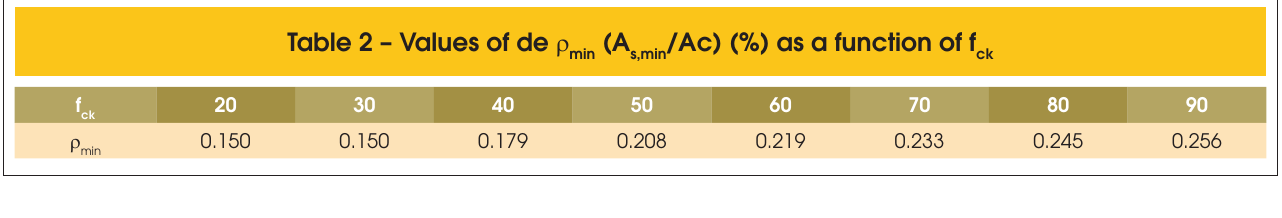
Table 2 – Values of de ρ